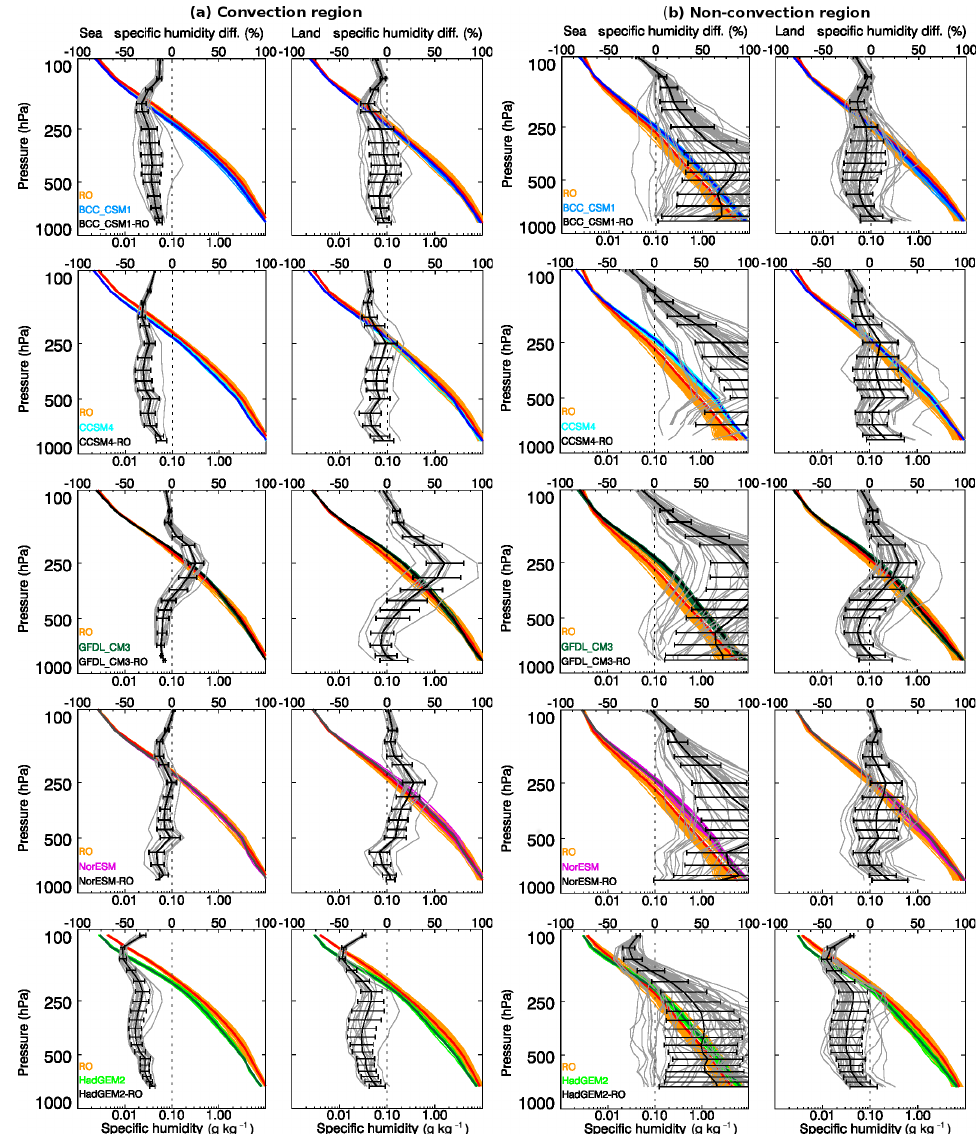
Figure 7. Specific humidity difference of model data minus RO observations (upper axes) and collocated specific humidity profiles (lower axes) for BCC-CSM1.1, CCSM4, GFDL-CM3, NorESM1-M, and HadGEM2 (top to bottom), shown for convection regions (a) over sea (left) and over land (right) and for non-convection regions (b) over sea (left) and over land (right). Mean and standard deviation of the differences are indicated in